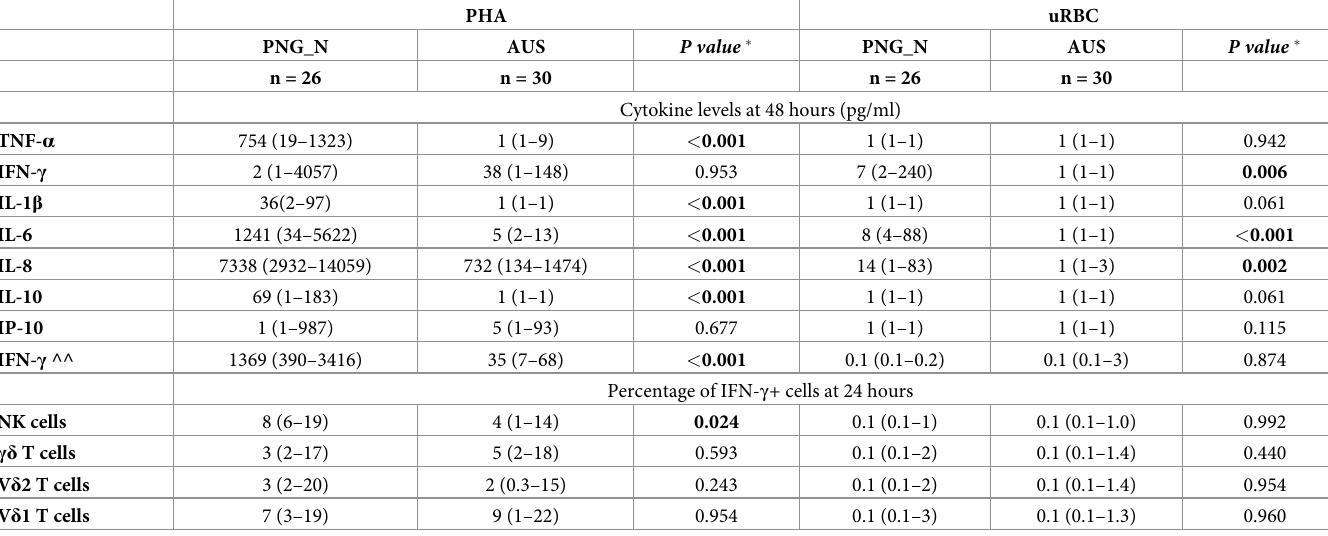
Table 5. Cytokine secretion and cellular responses to PHA and